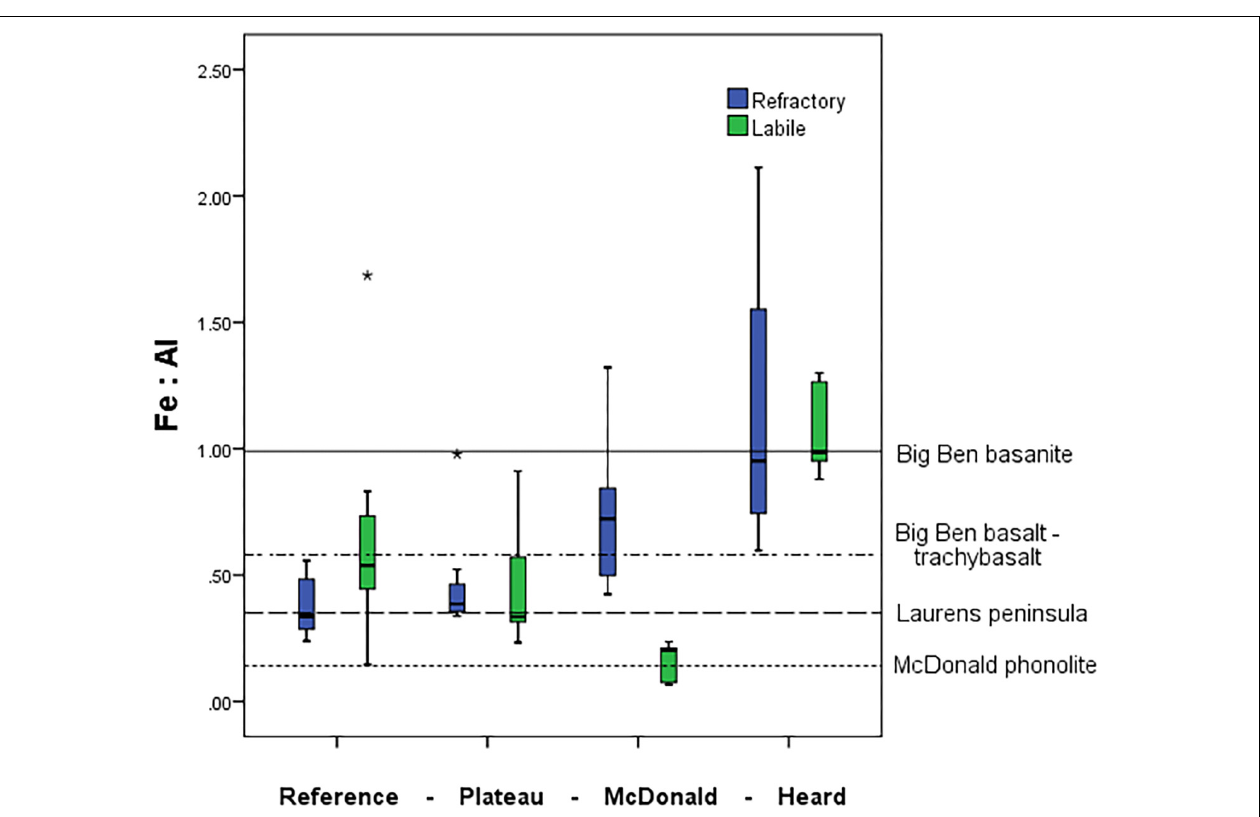
FIGURE 9 | Mean water column pFe:pAl molar ratio at the four contrasting regions within the study. Boxplots represent the labile particulate fraction in green and the refractory fraction in blue. Mean Fe:Al in rock samples from HIMI shown as horizontal lines from Barling et al. (1994). Big Ben basanite and basalt-trachybasalt was collected from several fresh lava flows around central Heard Island, while the samples from Laurens Peninsula were collected on the north-western peninsula of Heard Island. McDonald phonolite samples were collected from fresh lava flows on McDonald Island (Barling et al., 1994). Standard boxplot median (centre black line), 25th and 75th percentiles (upper and lower box limits) and 95% confidence intervals (inner fences) are indicated. Outliers are shown as circles ( < 1.5 × the interquartile range) and asterisk ( > 1.5 × the interquartile range). The number of independent data points for the reference, plateau, McDonald and Heard regions were 13, 13, 12, and 9 for pFe lab and 7, 8, 12, and 9 for refractory pFe, respectively.